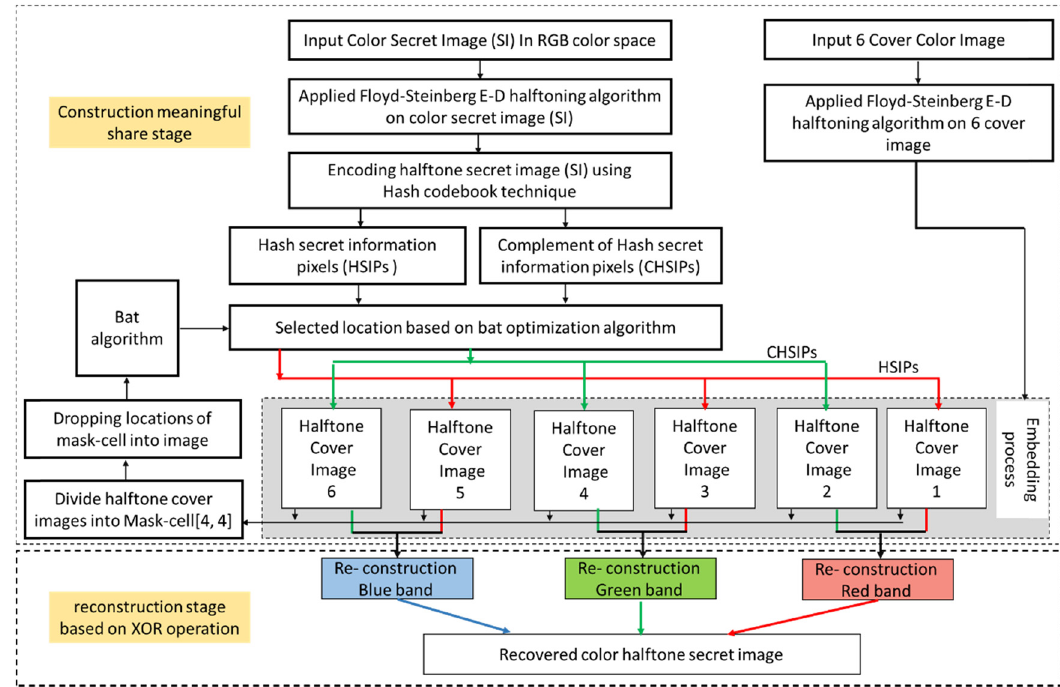
Figure 5: General block diagram of the